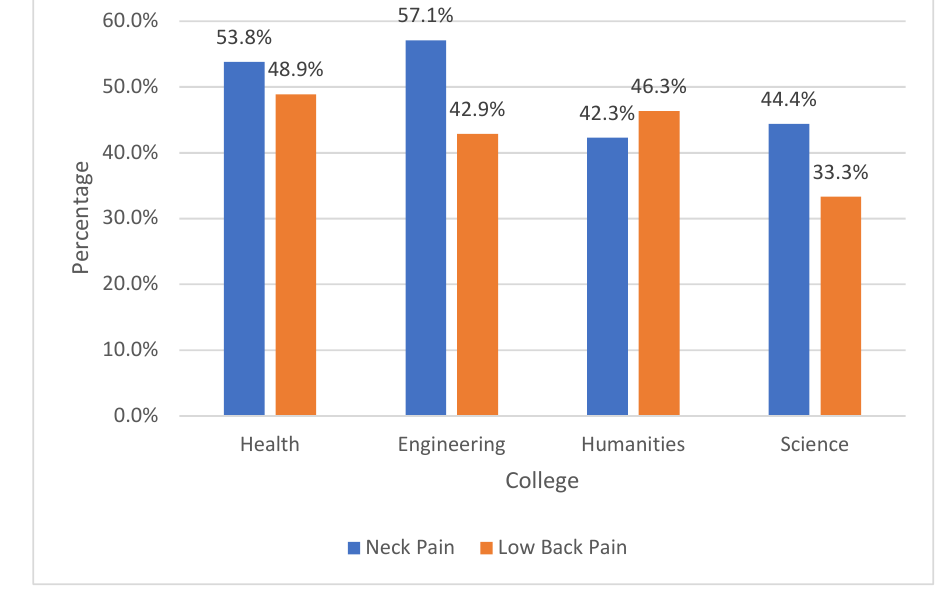
Figure 1. Prevalence of MSKP among university colleges in the past 12 months.